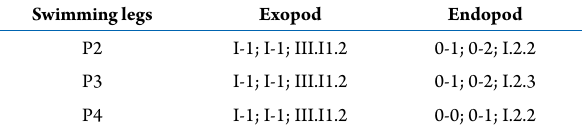
Table 1. Female Eudactylopus fasciatus Sewell, 1940. Armature formula of swimming legs. P2–P4, swimming legs